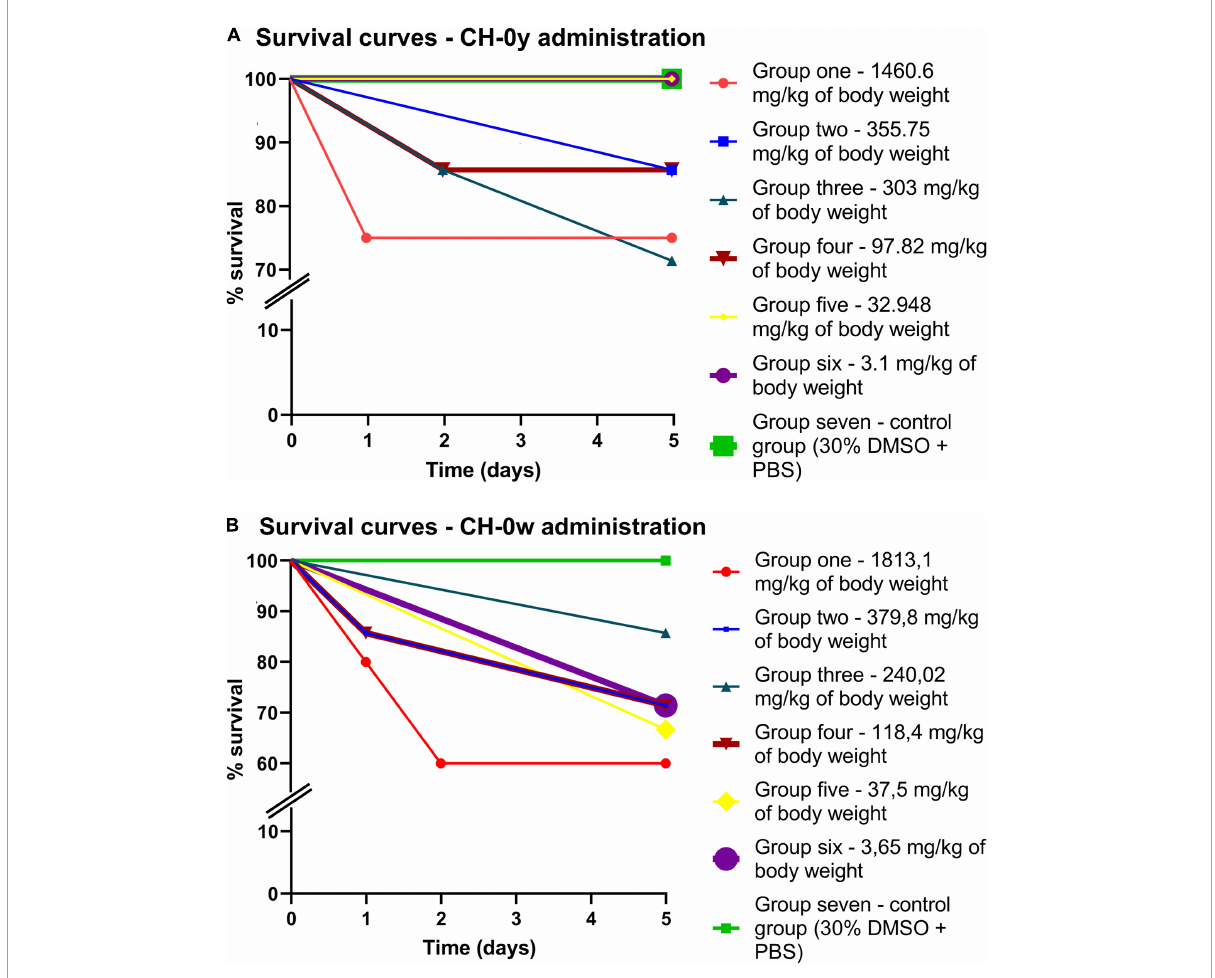
FIGURE2 Survival curves of animal model, Galleria mellonella , after intra-hemocoel administration of CH-0y (A) and CH-0w (B) . After administration, larvae were incubated at 37 ◦ C for 5 days and inspected after 24, 48, and 120 h of incubation.